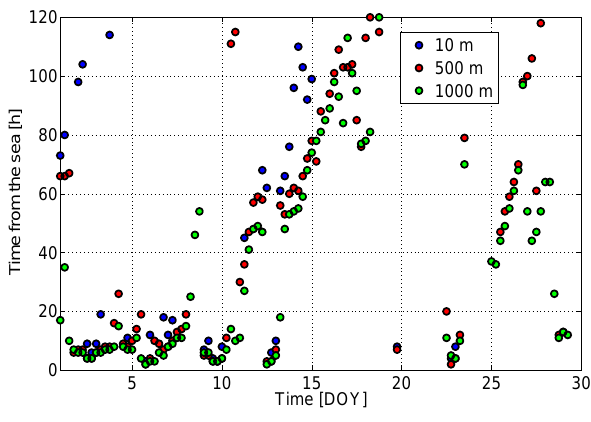
Fig. 3. Time of propagation (in hours) over the continent since last contact with the ocean calculated for trajectories arriving at Aboa at 10 (blue circles), 500 (red circles) and 1000 (green circles) m heights. Small number therefore corresponds to recent marine influ- ence. Trajectories were calculated 120h backwards every six hours. If the air mass spent the last 120h over the continent, no circle was plotted.